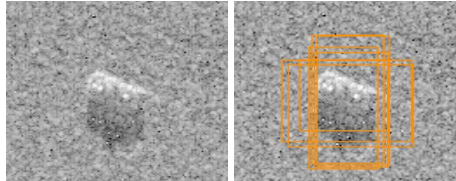
Figure 10. Test sample and the top seven candidate regions.